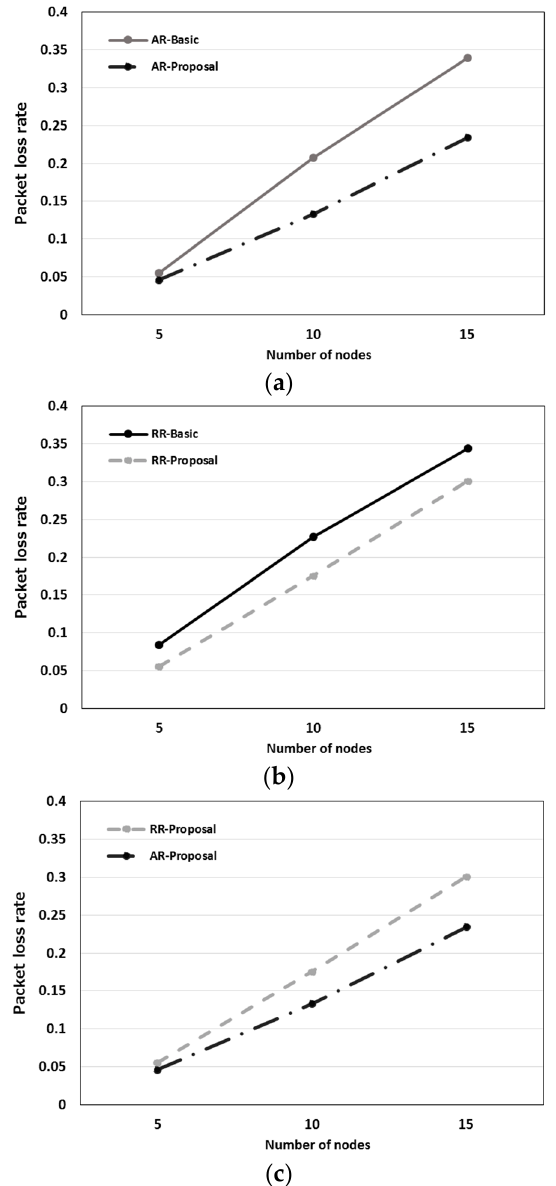
Figure 14. Packet loss rate: ( a ) Packet loss rates of the autonomous response-type stray node detection protocol; ( b ) packet loss rates of the request-response-type stray node detection protocol; ( c ) Packet loss rates of the two proposed protocols.